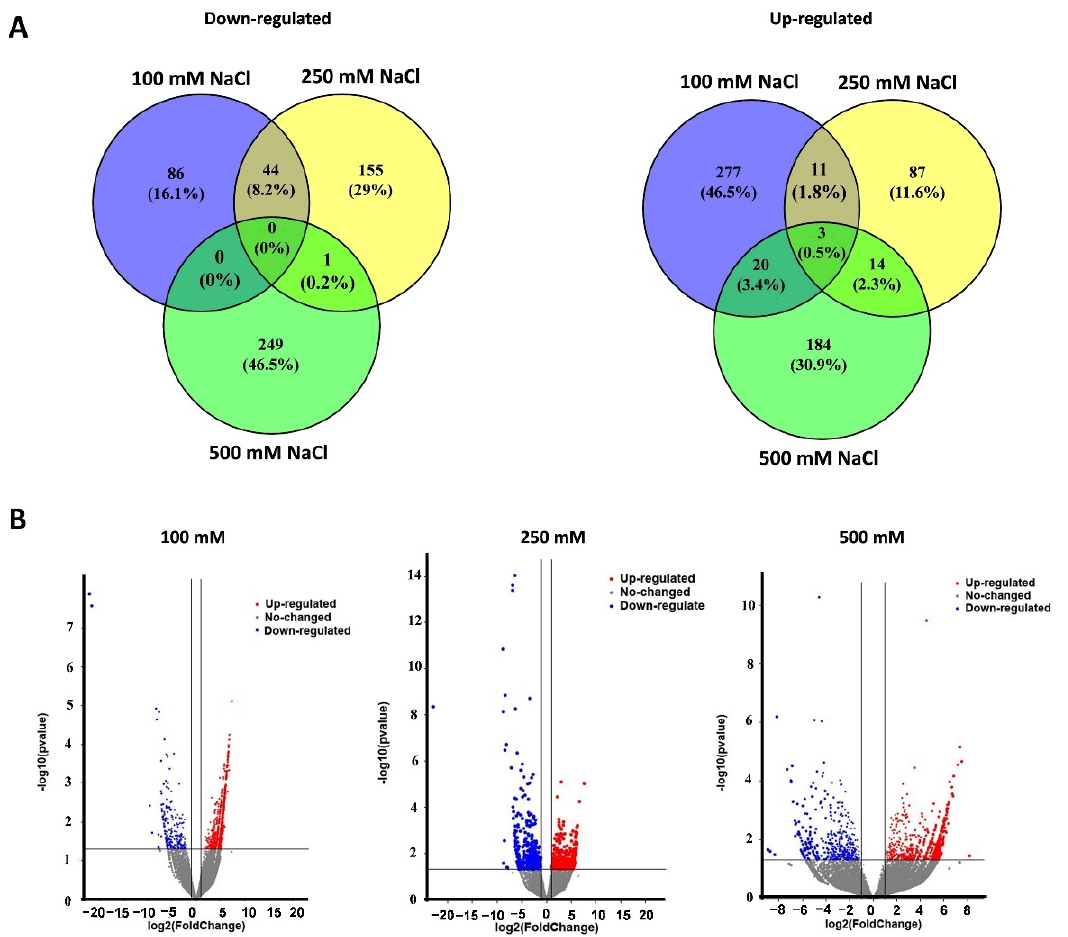
Figure 3. ( A ) The number of up- and down-regulated DEGs in the young leaves of oil palm seedlings under three level of salt stress: 100 mM NaCl, 250 mM NaCl, and 500 mM NaCl; ( B ) the p -value and log 2 foldchange (Log 2 FC) of all the genes.